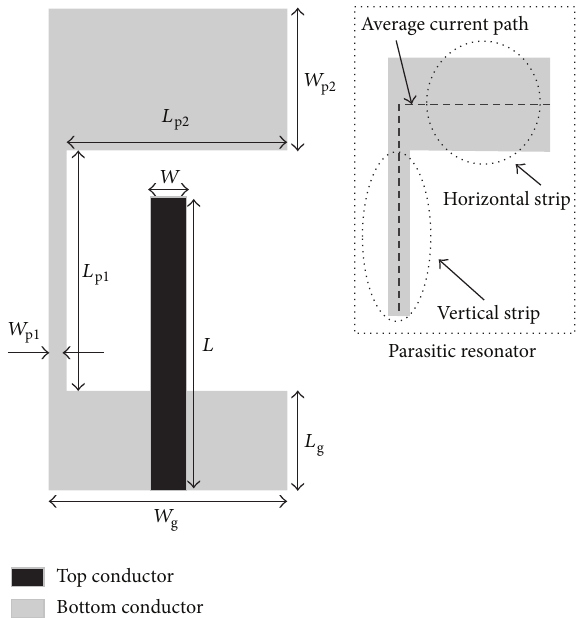
Figure 1: Geometry of the proposed dual-band monopole antenna.